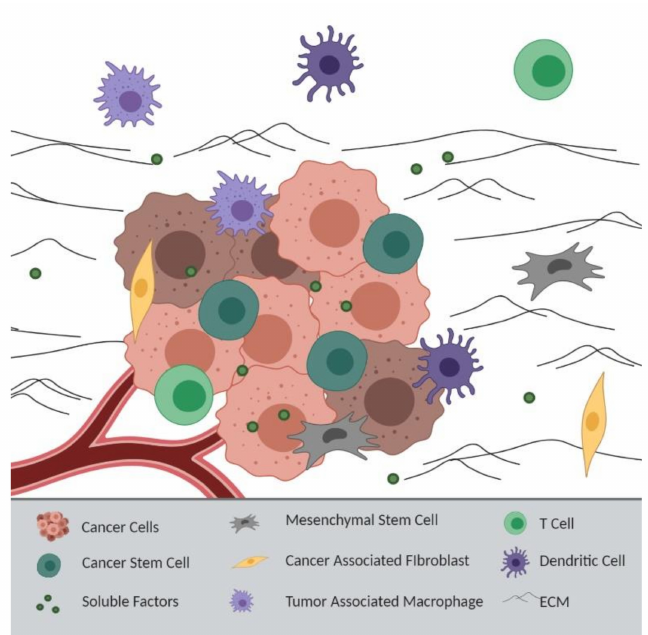
Figure 2. Tumor Microenvironment-Derived Resistance: Intercellular crosstalk between cancer cells and the tumor microenvironment (TME), including mesenchymal stem cells, cancer-associated fibroblasts, tumor-associated macrophages, T cells, and dendritic cells, promotes chemoresistance through the release of soluble factors. The extracellular matrix (ECM) can also act as a barrier to chemotherapeutics, and similarly, a limited blood supply to the tumor can prevent drug accumulation at the tumor site. Images made with